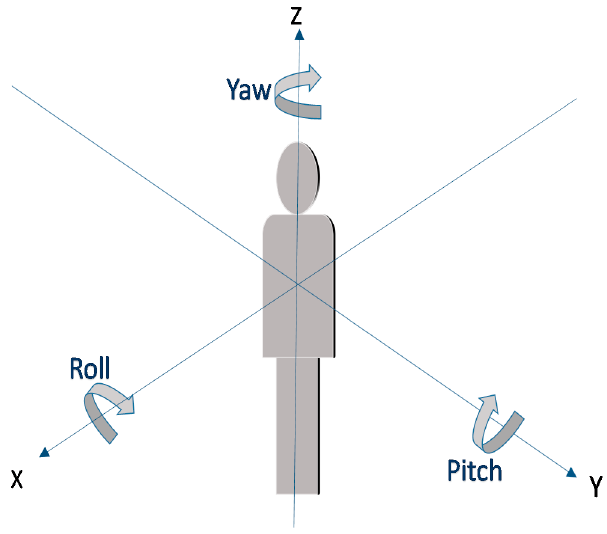
Figure 4. Pitch, roll, and yaw angle of the human body.